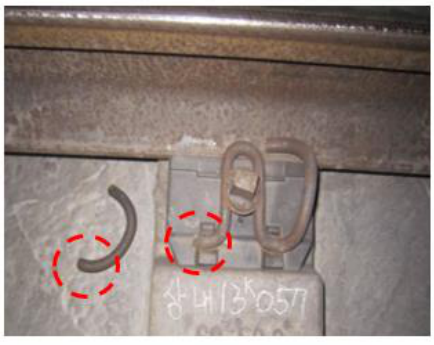
Figure 1. Damaged rail clip.